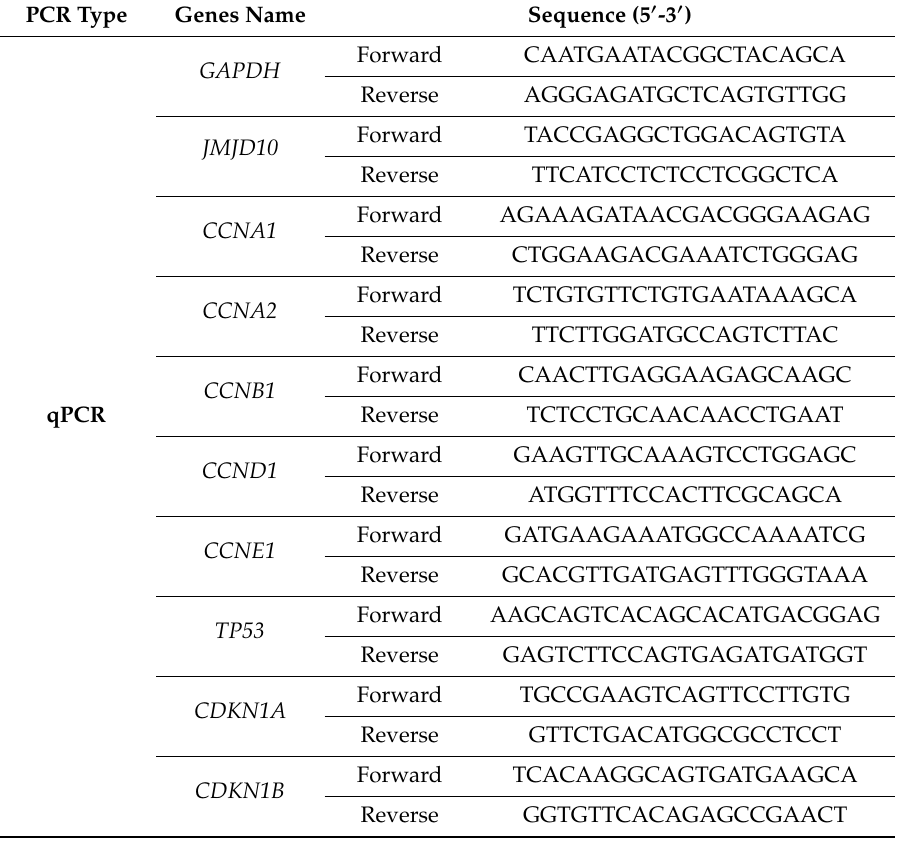
Table 2. Primer sequences used for